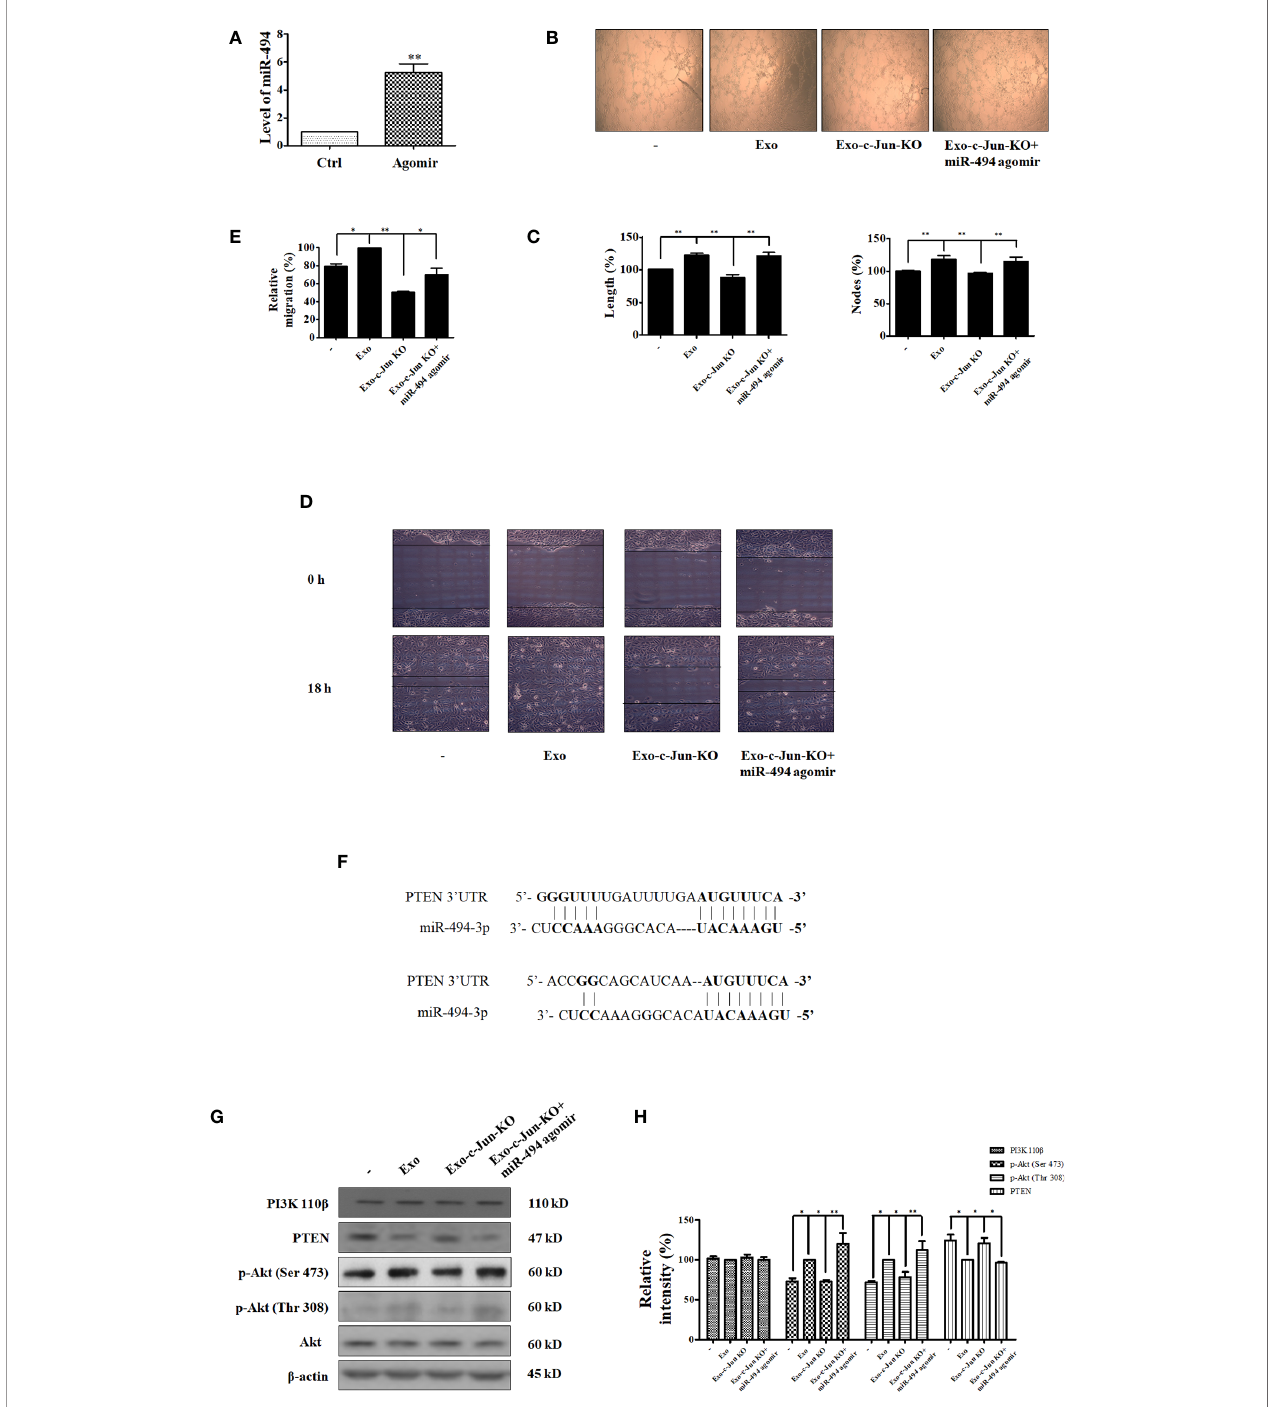
FIGURE 4 | miR-494/PTEN is involved in angiogenesis inhibited by Exo-c-Jun-KO (A) The level of miR-494 in HUVECs transfected with the miR-494 agomir or agomir NC. (B) Tube formation of HUVECs treated with Exo, Exo-c-Jun-KO, and those simultaneously transfected with miR-494 agomir or agomir NC. (C) Length (%) and Nodes (%) were determined by Image J software. (D) Migration of HUVECs treated with Exo, Exo-c-Jun-KO, and those simultaneously transfected with miR-494 agomir or agomir NC. (E) Quanti fi cation of the results in (D) . (F) PTEN as the target gene of miR-494. (G) Changes of PTEN/Akt related proteins in HUVECs treated with or without Exo or Exo-c-Jun-KO, and those simultaneously transfected with miR-494 agomir or agomir NC. (H) Quanti fi cation of the results in (G) . Data show the mean ± SD of three independent experiments. *p < 0.05 and **p <